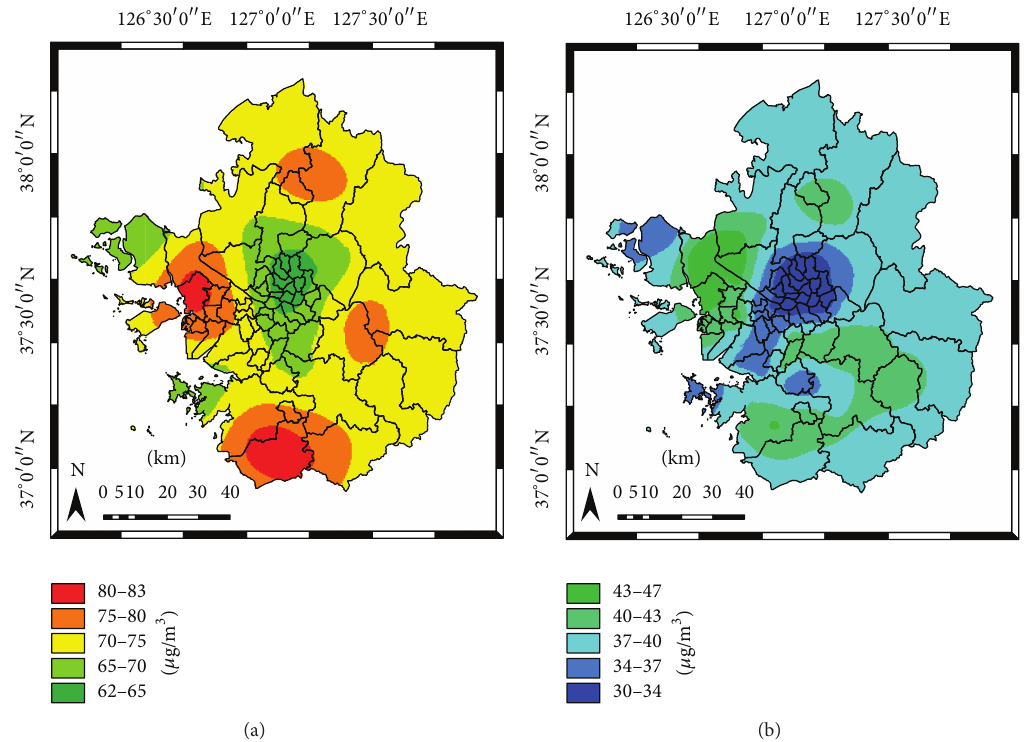
Figure 6: PM 10 concentration for (a) April 2009 and (b) August